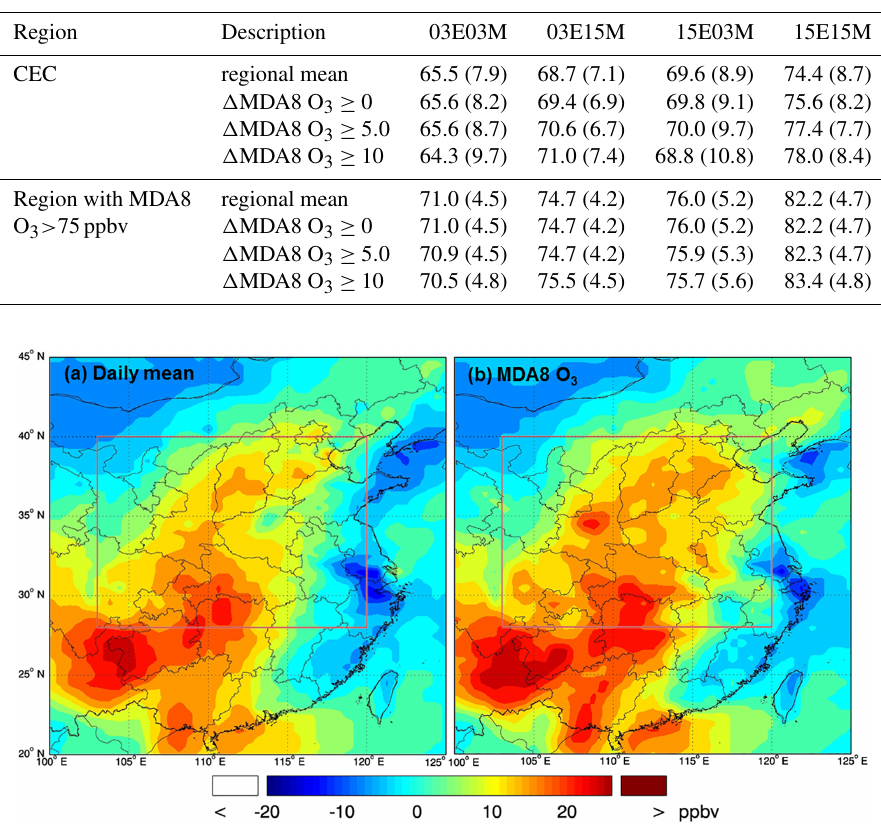
Figure 3. Differences in monthly mean surface O 3 in July of 2003 and 2015 (2015–2003) for daily mean O 3 (a) and MDA8 O 3 (b) simulated by 2003 and 2015 standard